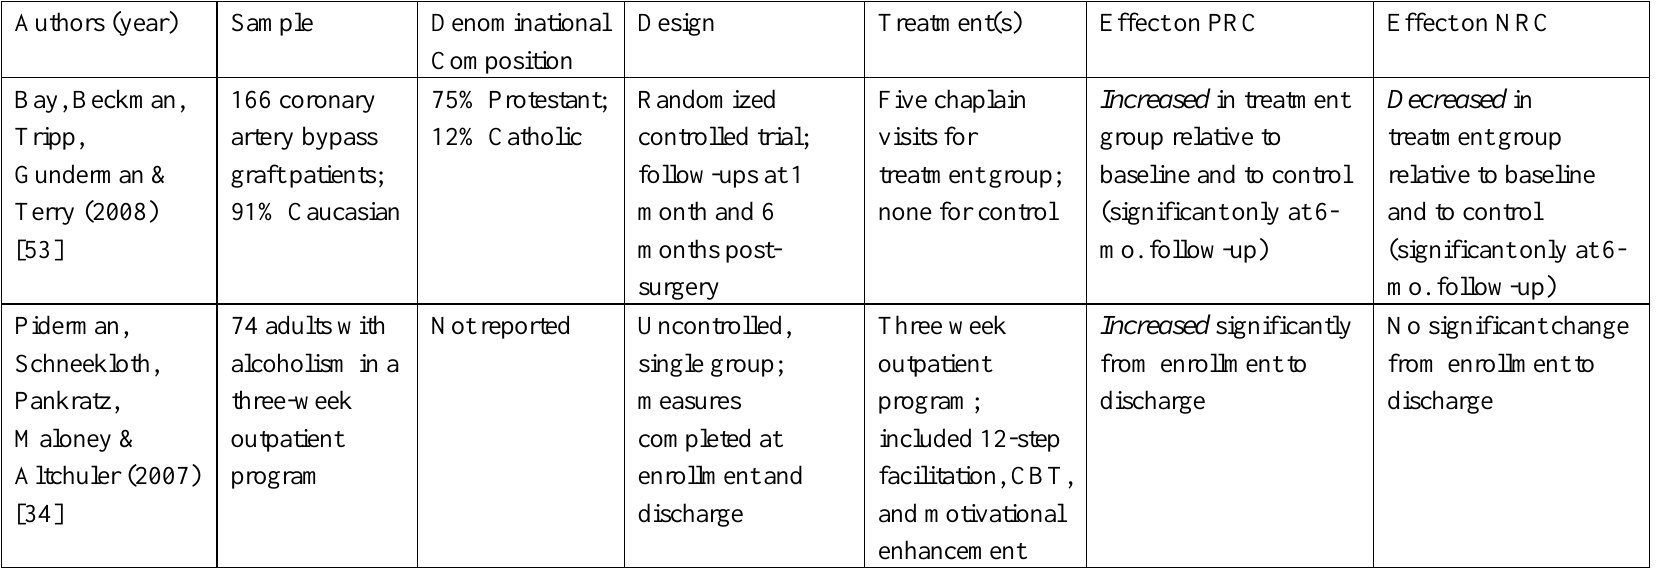
Table 5. Sensitivity to